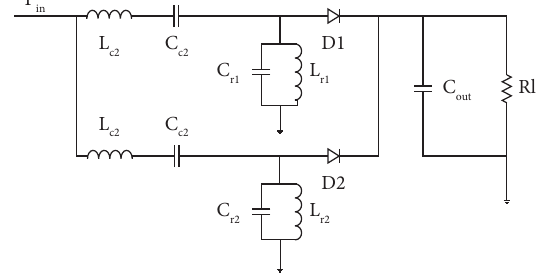
Figure 24: Rectifer of two branch adopting the second